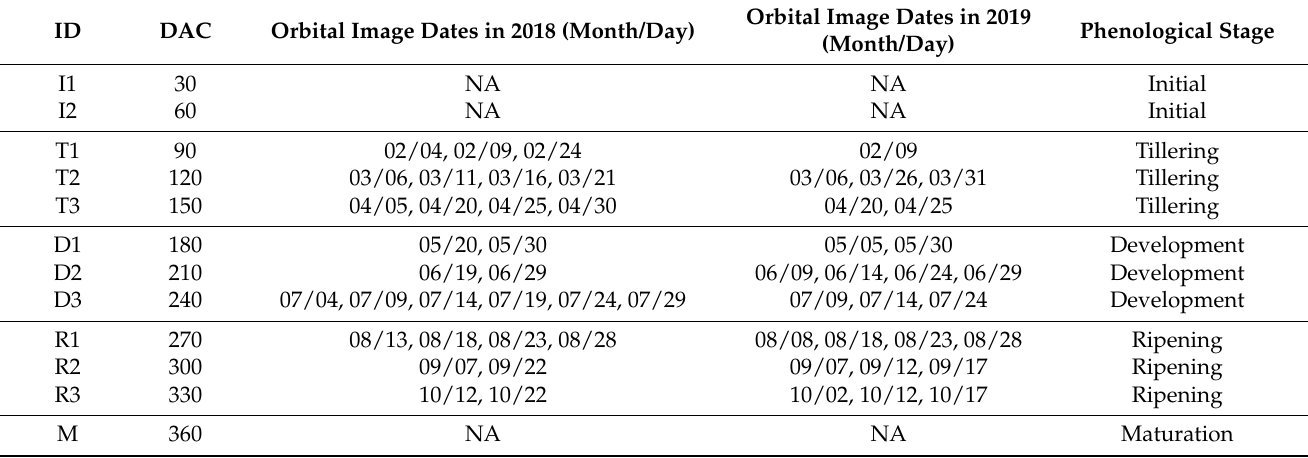
Table 3. Dates of the orbital images and respective phenological stages of